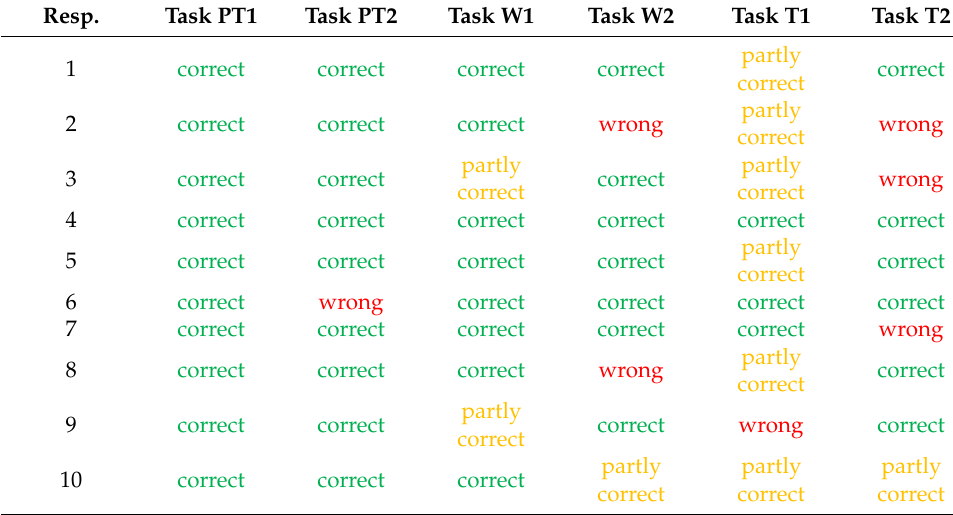
Table 2. Evaluation of the tasks from user testing. Resp. Task PT1 Task PT2 Task W1 Task W2 Task T1 Task T2